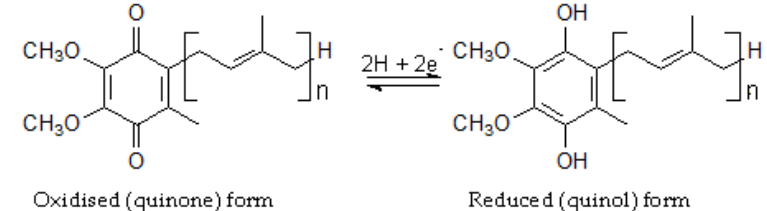
Figure 1. The oxidised and reduced forms of Coenzyme Q (CoQ). The oxidised and reduced forms of CoQ are interconverted by the addition or loss of 2H + 2e − . n = 10 in humans and 9 in rats and mice.